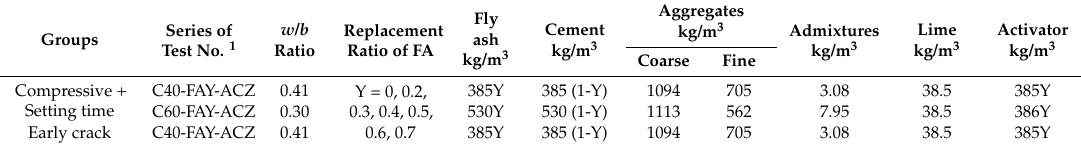
Table 2. Mix proportions of